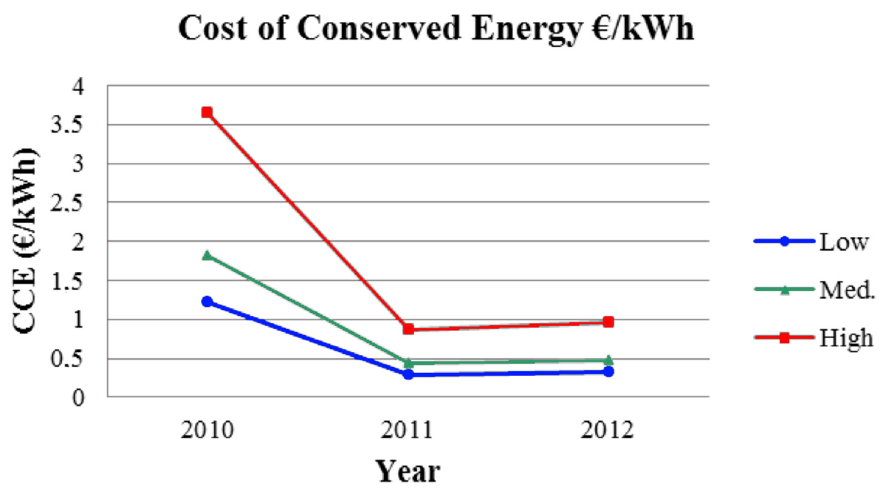
Figure 10. Annual trends of cost of conserved energy for three efficiency base case scenarios—real discount rate.